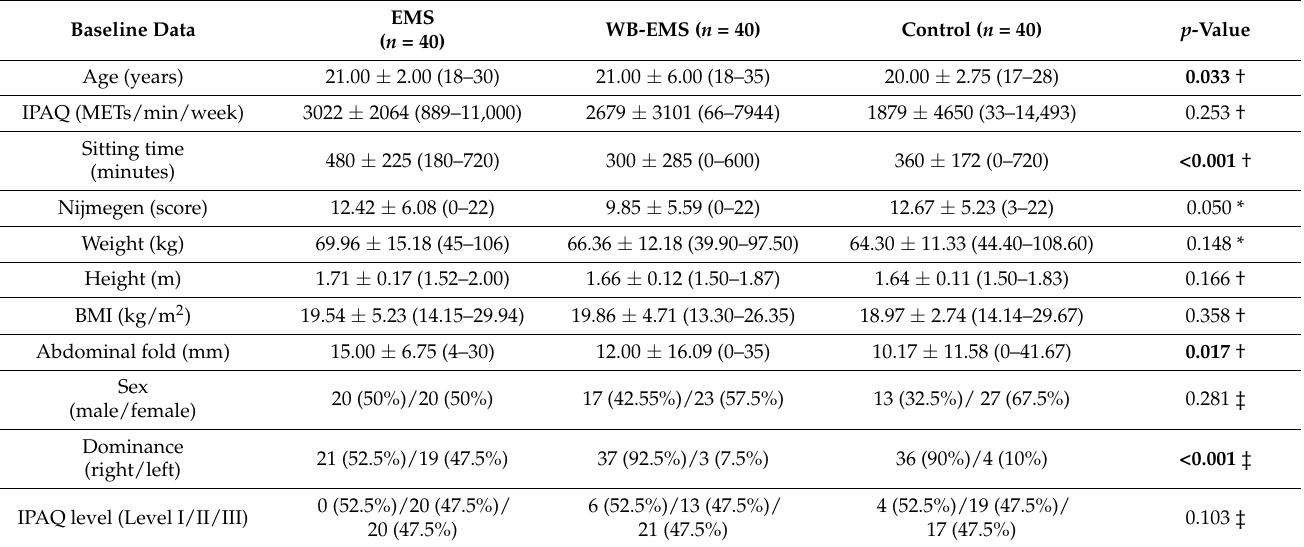
Table 2. Descriptive data comparisons among the EMS, WB-EMS, and control groups.